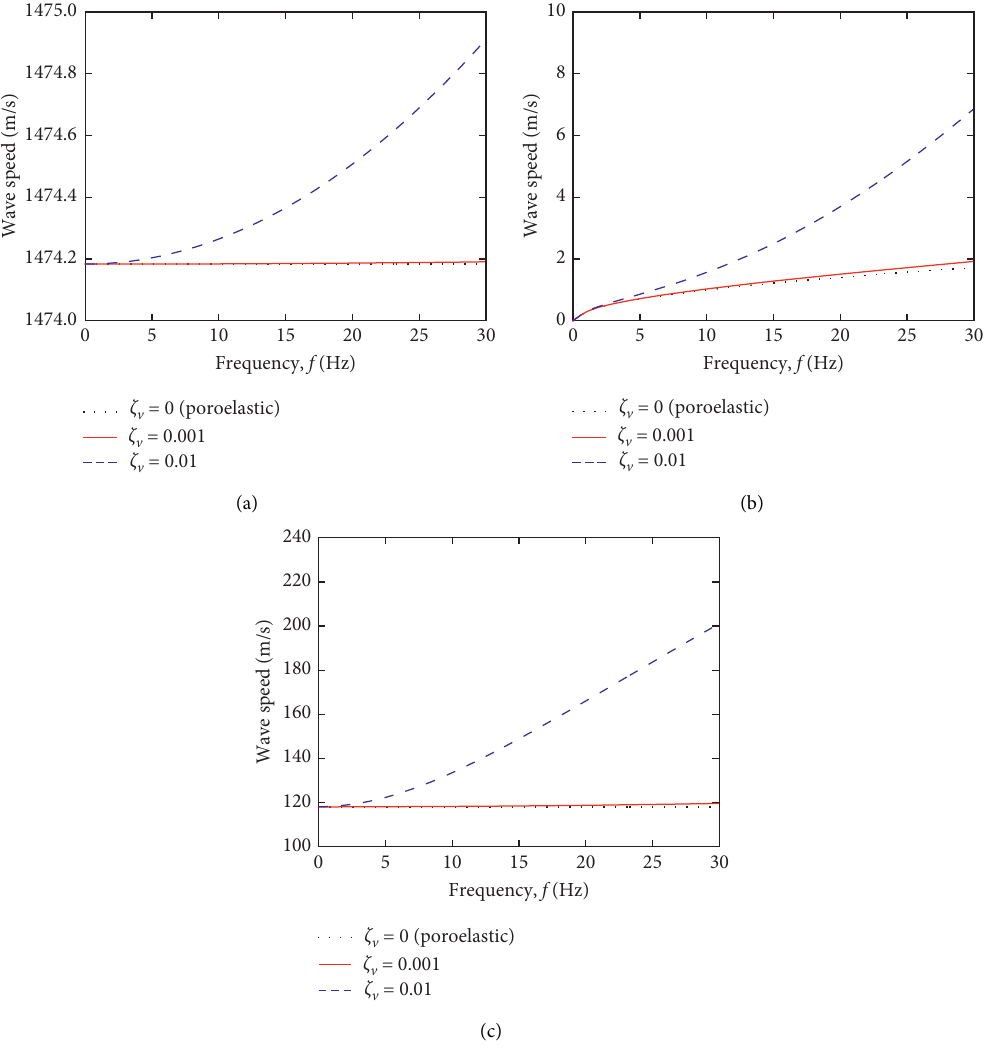
Figure 2: Variation of wave speeds of P1, P2, and S waves with frequency. (a) P1 wave. (b) P2 wave. (c) S